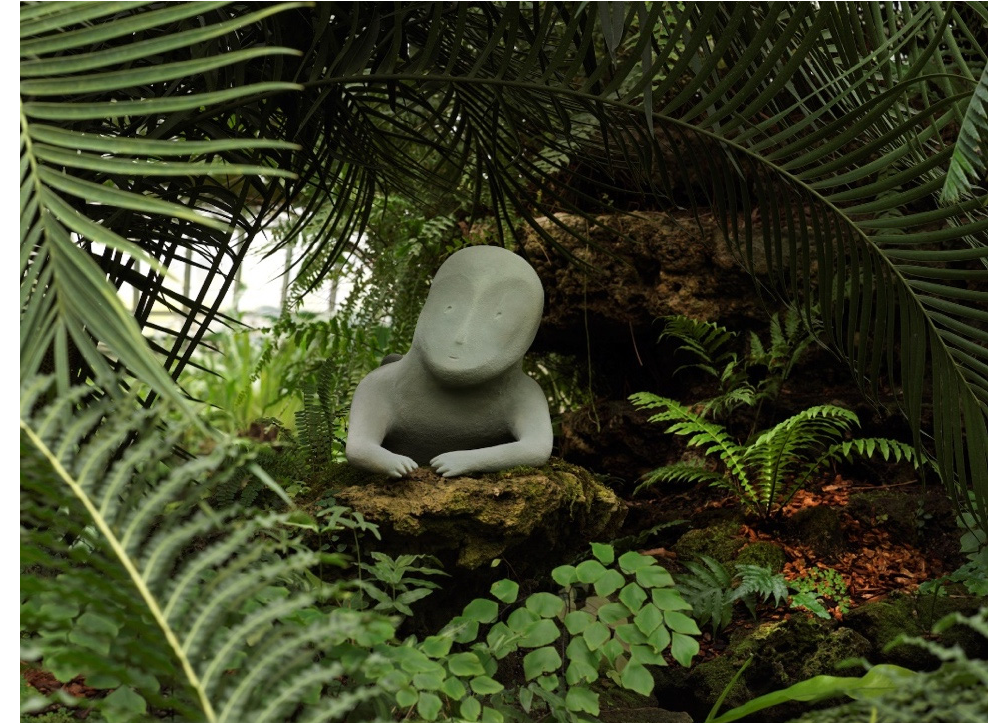
Figure 3. A Genius of the Spot IV, 2020, glazed ceramic, 14 ″ × 33 ″ × 10 ″ .